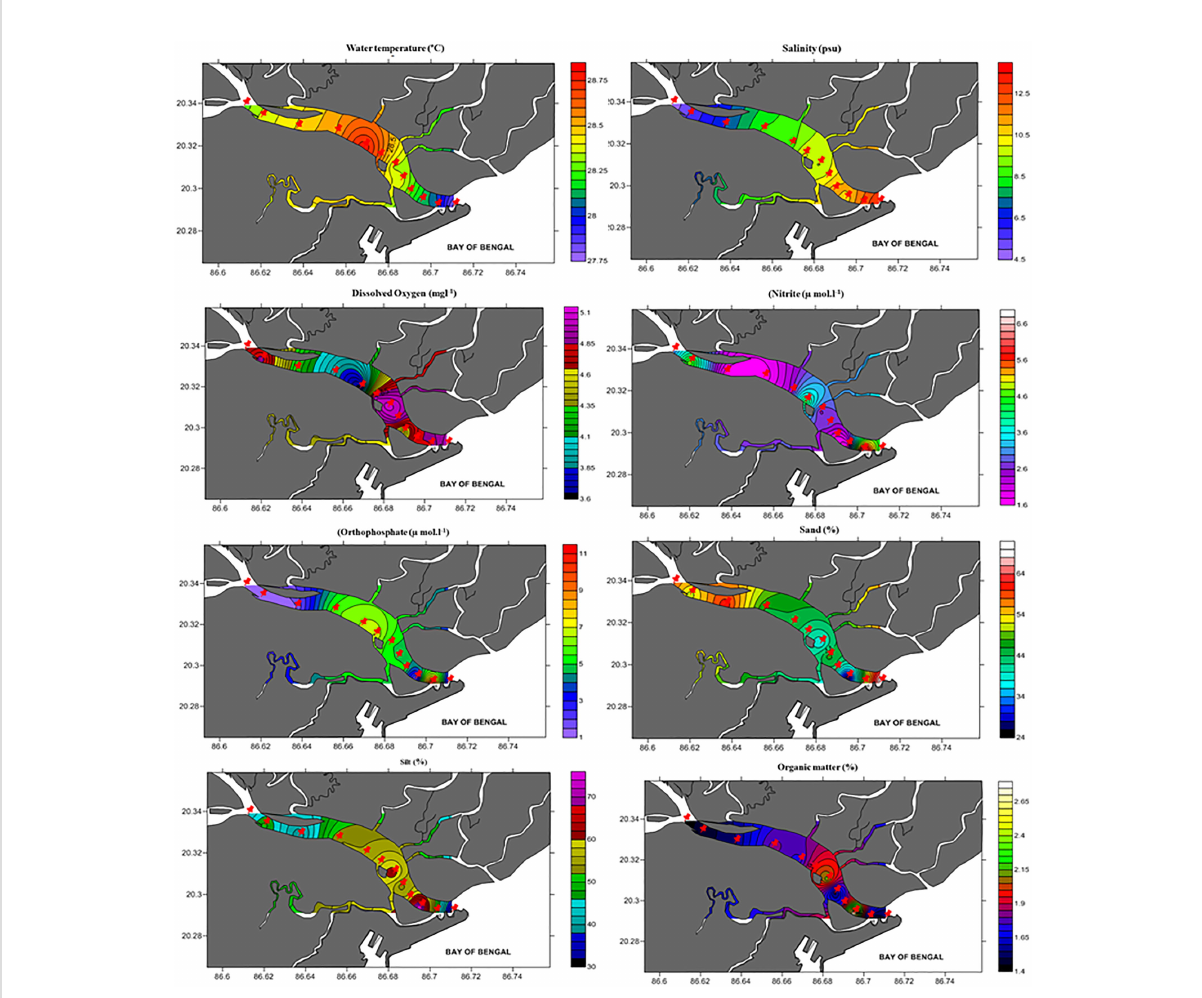
FIGURE 2 Spatial distribution patterns of hydrographical (water temperature, salinity, dissolved oxygen, nitrite, and orthophosphate) and sediment (sand, silt, and organic matter) variables in Mahanadi